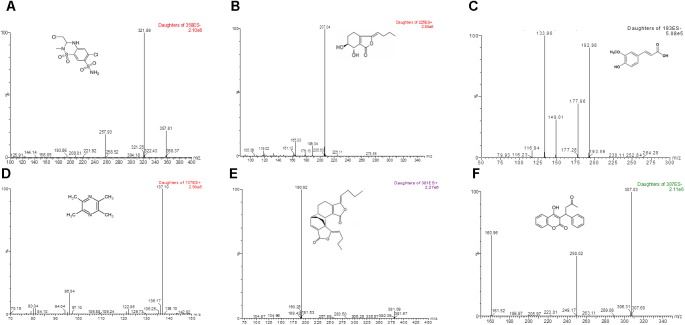
LC-MS/MS spectra of methyclothiazide, four marker compounds of Chuanxiong and warfarin. Methyclothiazide, warfarin, and ferulic acid can be ionized under negative ionization conditions, levistilide A, senkyunolide I, and tetramethylpyrazine ionized under positive ionization conditions. The most sensitive mass transitions for methyclothiazide [(A) the internal standard] were 357.81→321.89. for senkyunolide I (B) were 225.11→207.04, for ferulic acid (C) were 192.98→133.96, for tetramethylpyrazine (D) were 137.10→96.04, for levistilide A (E) were 381.09→190.92 and for warfarin (F), were m/z 307.03→250.02.